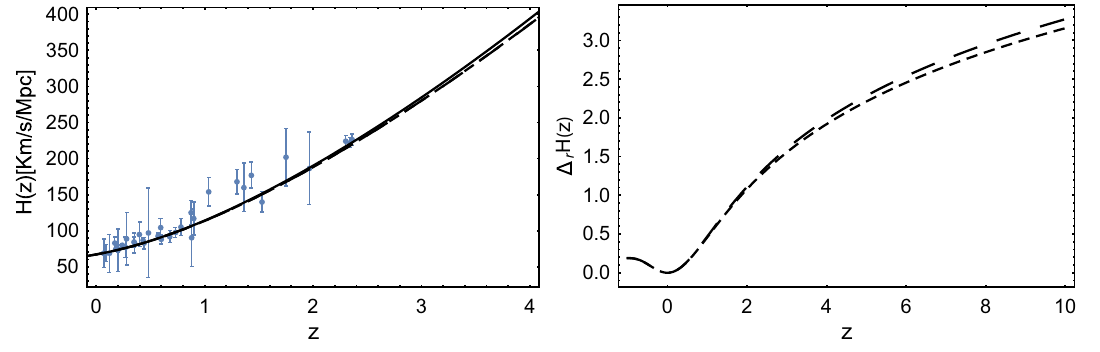
Fig. 3 It is shown the evolution of the Hubble rate H ( z ) (left panel) as a function of red-shift z , for the G -varying model defined in Eq. (79), with the coupling function Q = 3 ν dm H ρ dm , representing the interaction between dark energy and dark matter, for ν m = 0 . 01 and ν = 1 × 10 − 3 (dashed line), as also, the Hubble rate of (cid:2) CDM model, G along with the Hubble data from Refs. [79], and [80]. In the right panel